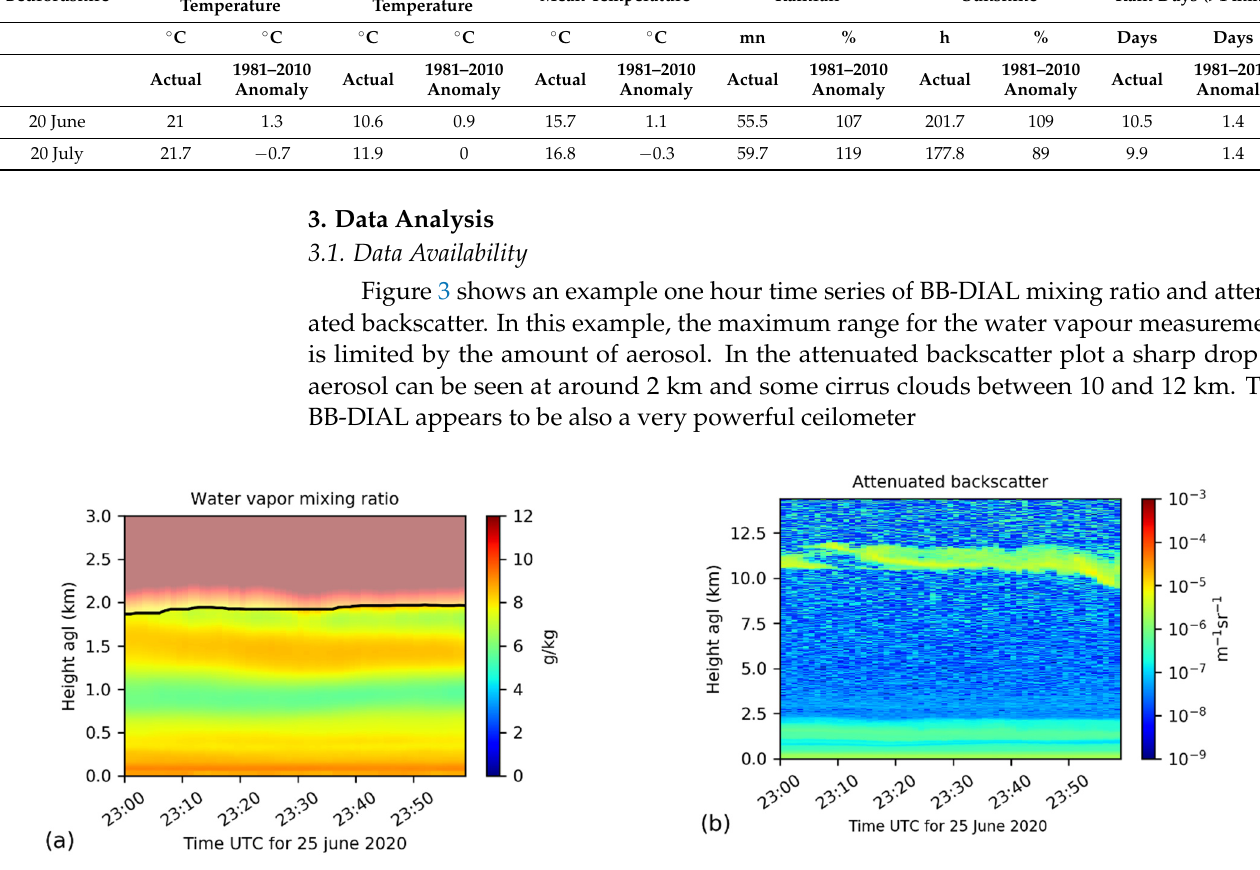
Figure 3. Example of one-hour time series of ( a ) water vapour mixing ratio (the black line indicates the maximum height for trusted water vapour measurement) and ( b ) attenuated backscatter. Note that BB-DIAL backscatter was not calibrated in this study, so the unit is arbitrary.